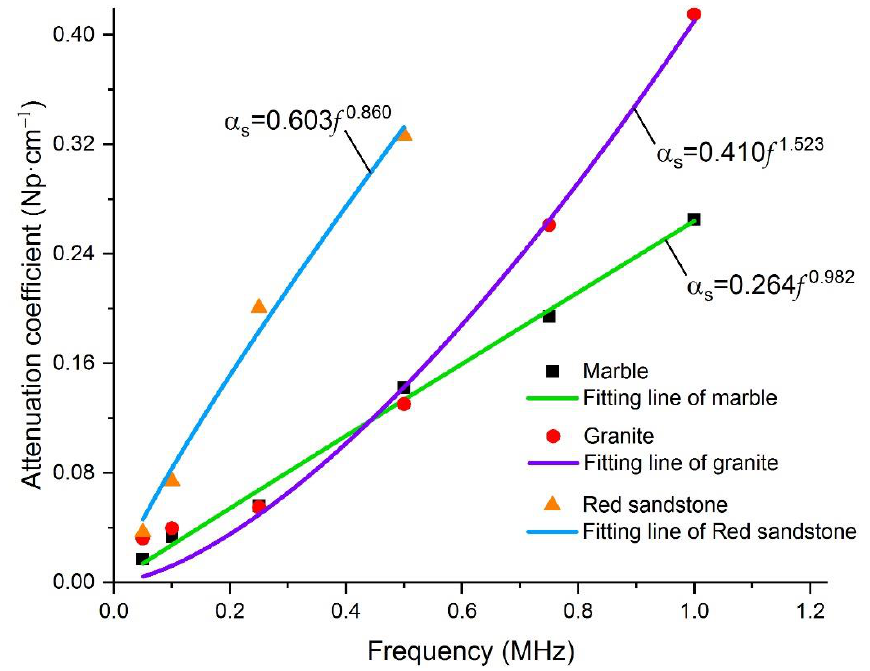
Figure 8. Relationship between 𝛼 𝑠 of the specific frequency components and 𝑓